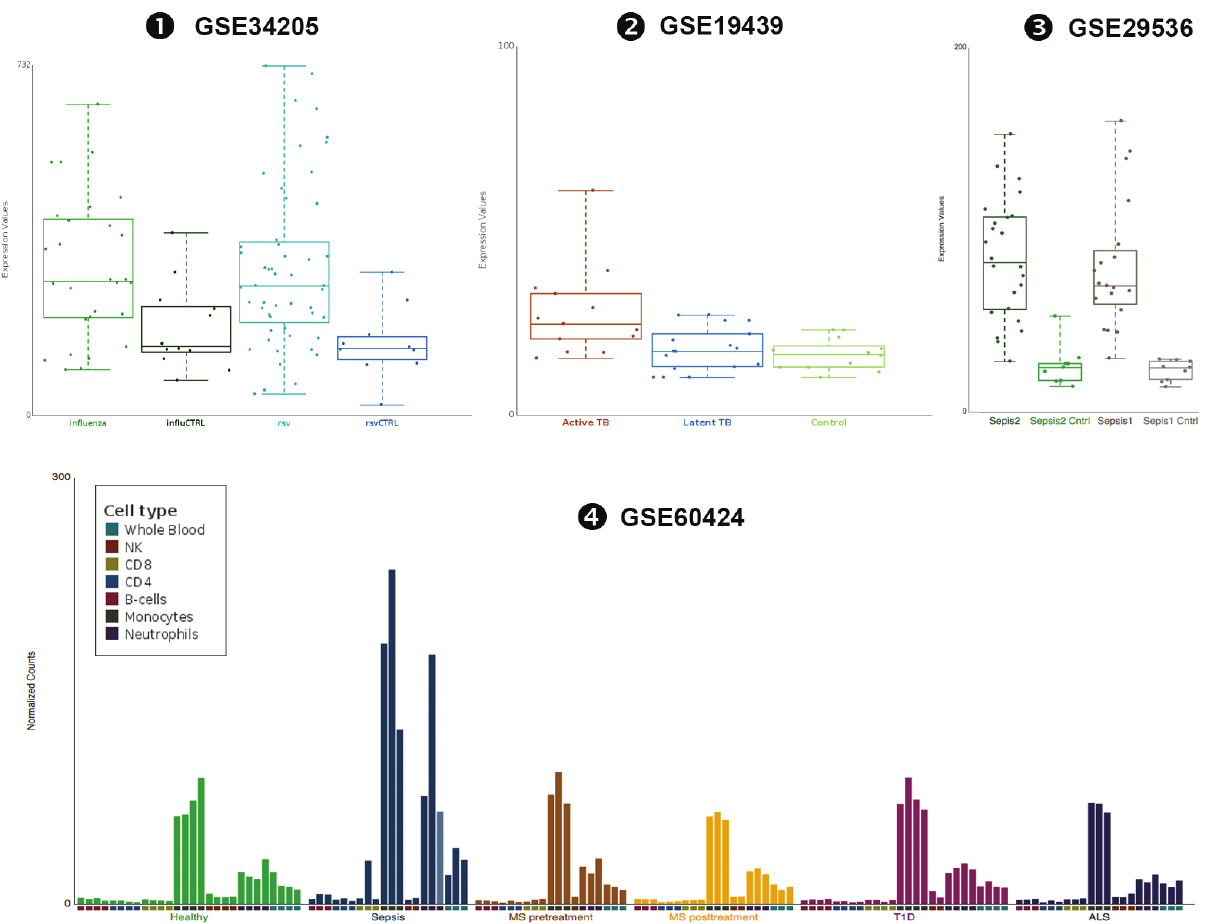
Supplementary Figure 2. These plots are exported directly from the GXB tool and show data supporting the notion that the abundance of ADAM9 increases during infection as presented in Figure 2 of the manuscript. The interactive version of this plot can be accessed via the links provided